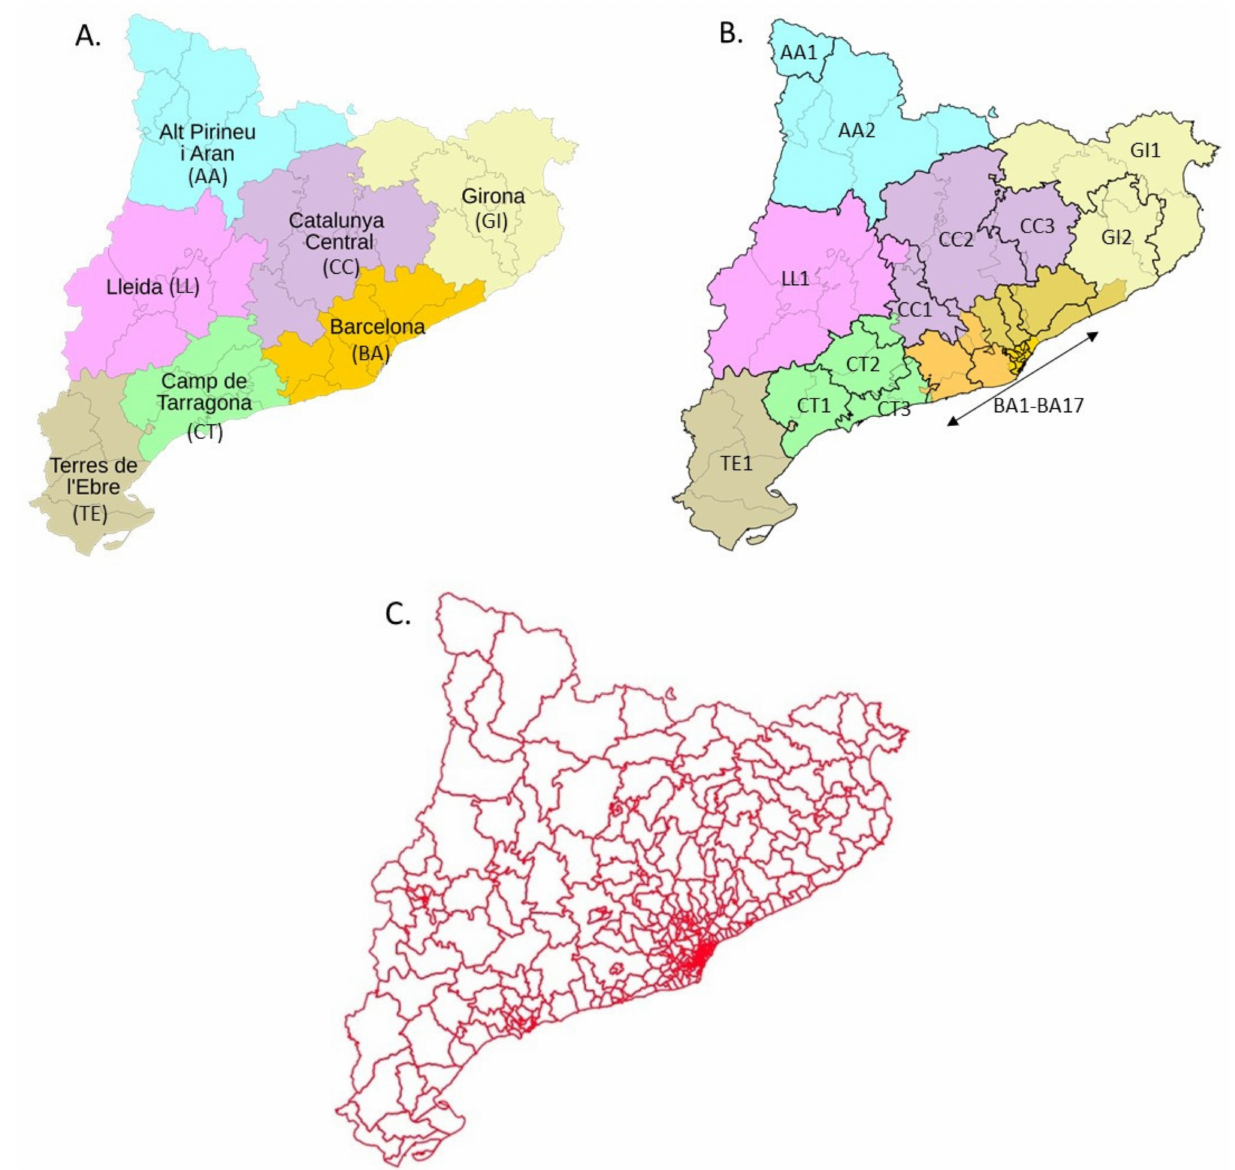
Figure 1. Health map of Catalonia distributed into health regions ( A ), health sectors ( B ), and basic health areas ( C ). The names of the health regions are included in panel ( A ) and the codes of both the health regions and the health sectors are also included in panels ( A ) and ( B ), respectively. Health sector codes are based on the health sector root